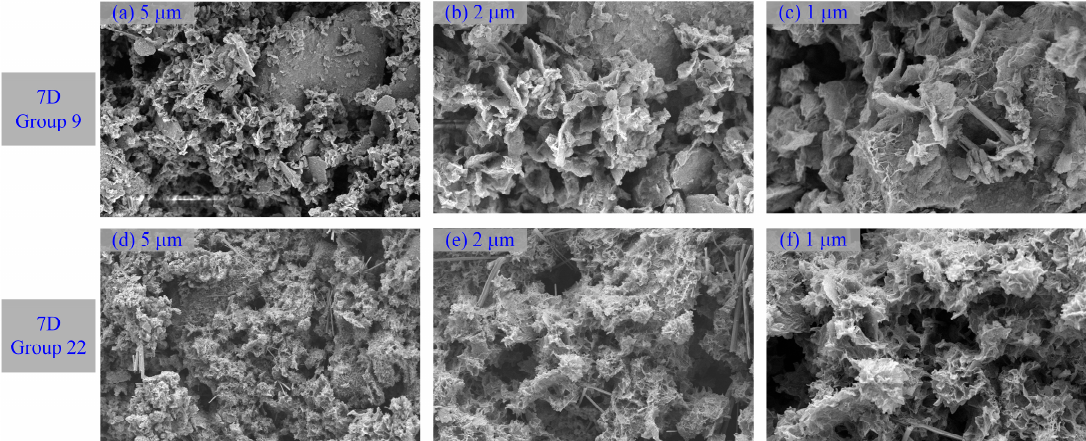
Figure 15. SEM photomicrographs of DWS-GM with 7 days of curing. 7D Group 9: ( a ) 2.0KX ( b ) 5.0KX ( c ) 10.0KX 7D Group 22: ( d ) 2.0KX ( e ) 5.0KX ( f ) 10.0KX.